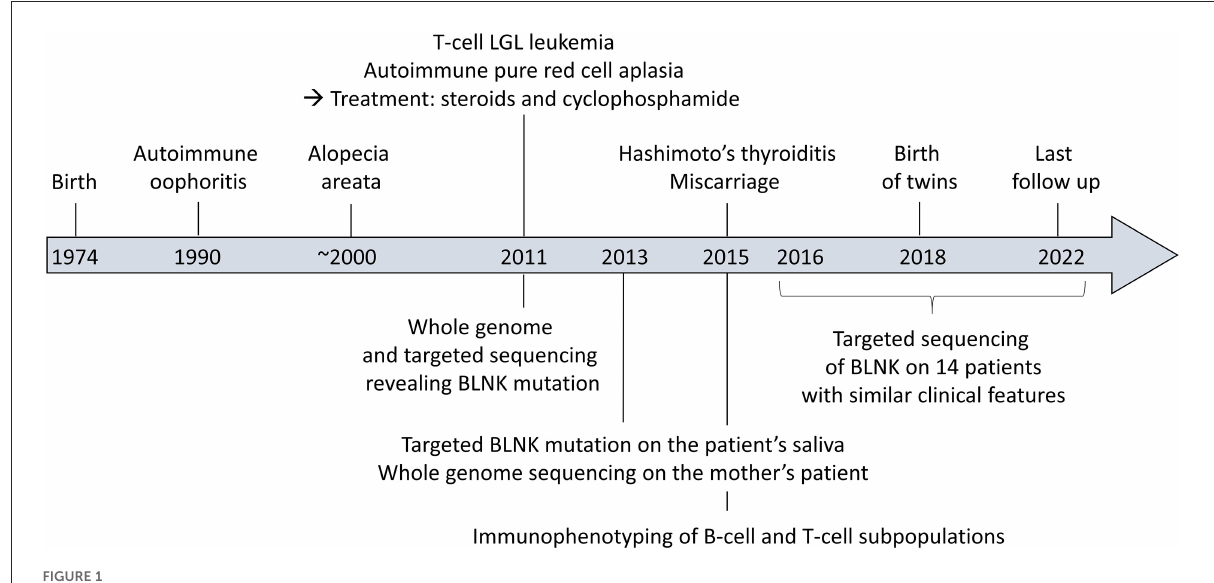
FIGURE1 Timeline of the clinical case.